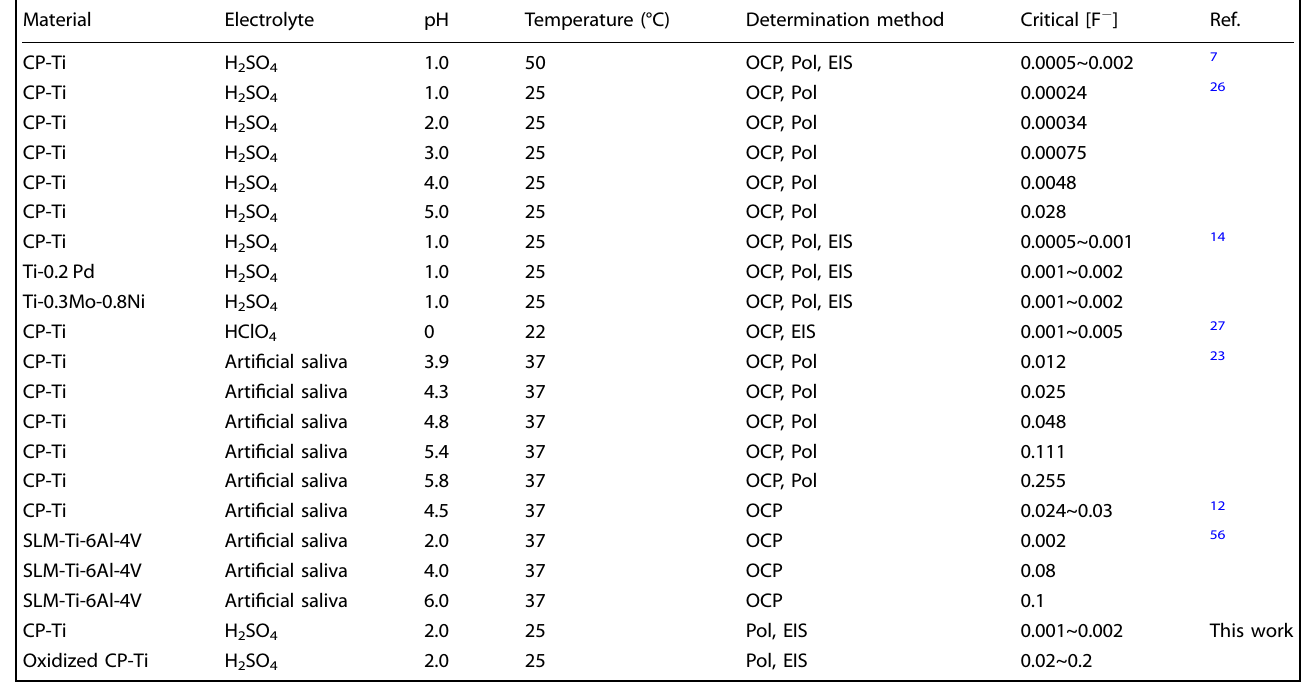
Table 2. Comparison of the critical fl uoride concentration of pure Ti and its alloys in the literature with the present work. Material Electrolyte pH Temperature (°C) Determination